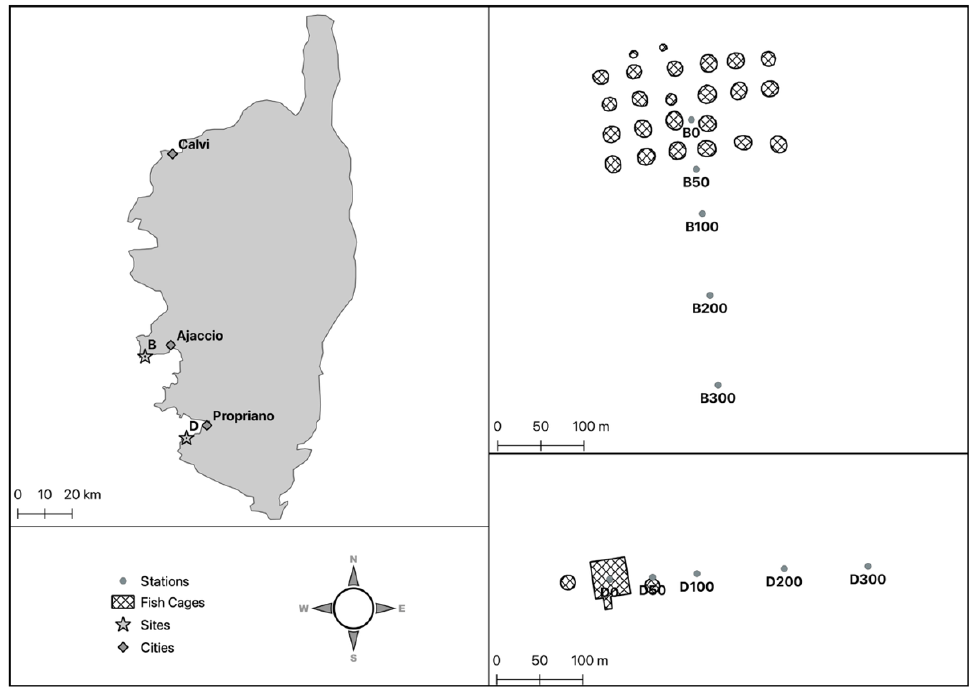
Figure 1. Sampling sites (B and D) along the Corsican coast. Sites are represented by stars and stations by grey circles. Stations are named according to their distance (in meters) from fish farms.